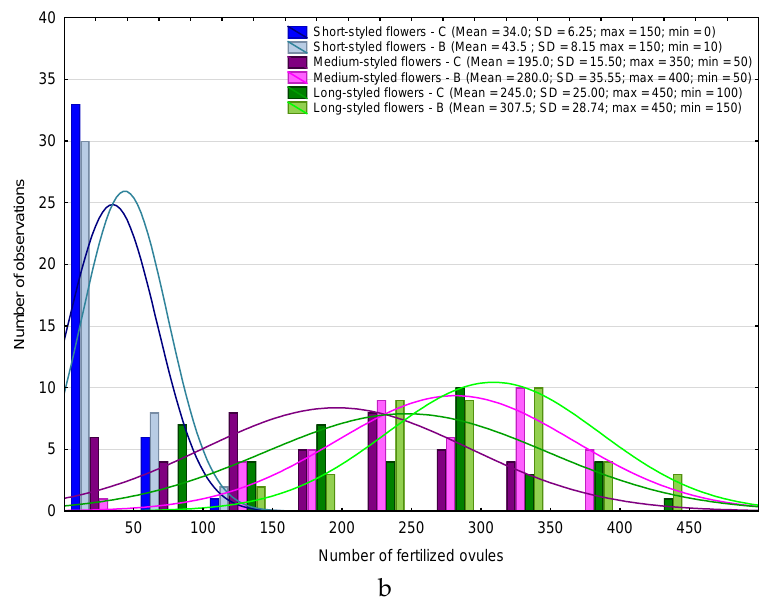
Figure 9. Number of pollen tubes ( a ) and fertilised ovules ( b ) in the styles of different flower types in ”Gascona” F 1.